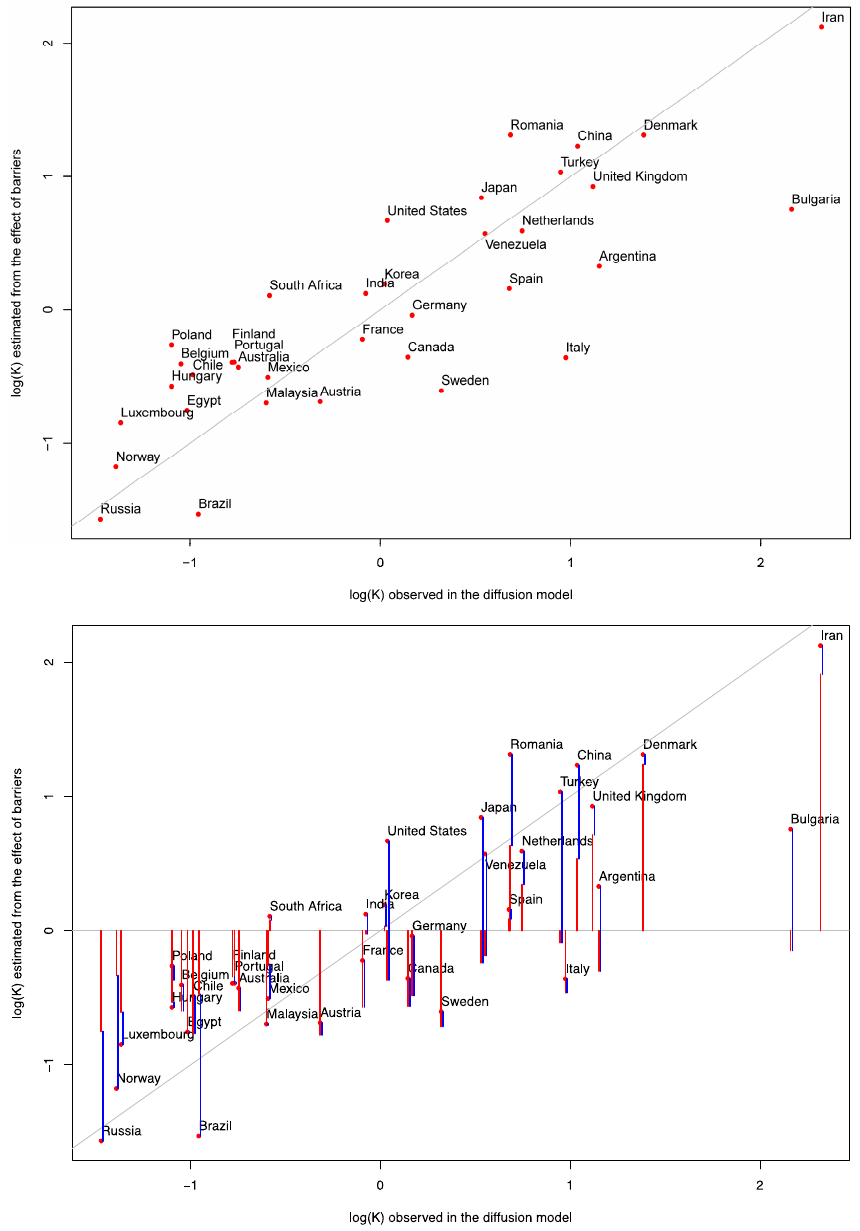
Figure 3. Upper panel: observed vs estimated values of parameter K that summarises the effect of the barriers. Lower panel: contribution of the terms of model 1 and 2 to the K estimated by model 3.